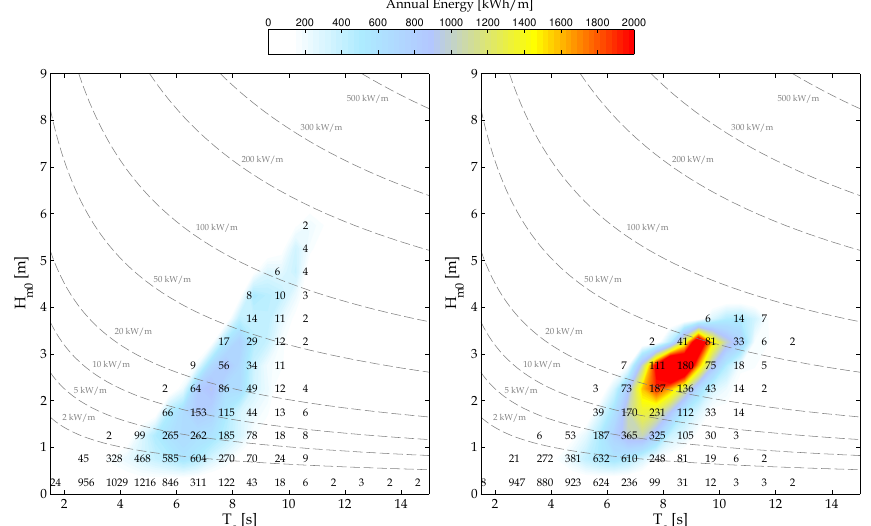
Figure 12. Characterisation of the yearly average wave energy in terms of significant wave height H m 0 and energy period T e : on the left site HS1 and on the right site HS2. The colour scale represents annual energy per metre of wave front (in MWhm − 1 ). The numbers within the graph indicate the occurrence of sea states (in number of hours per year).